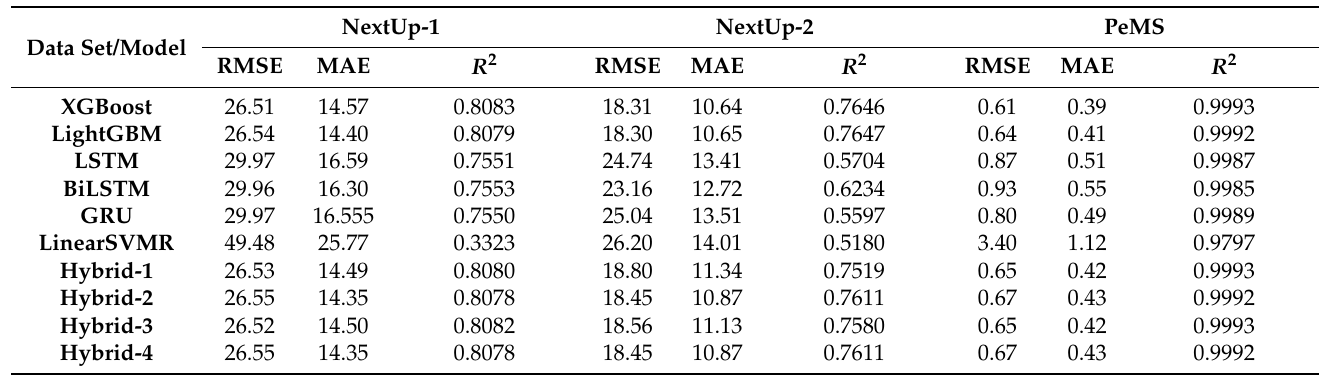
Table 4. Performance Metrics of 10 Models across Three Data Sets: Evaluation Metrics.